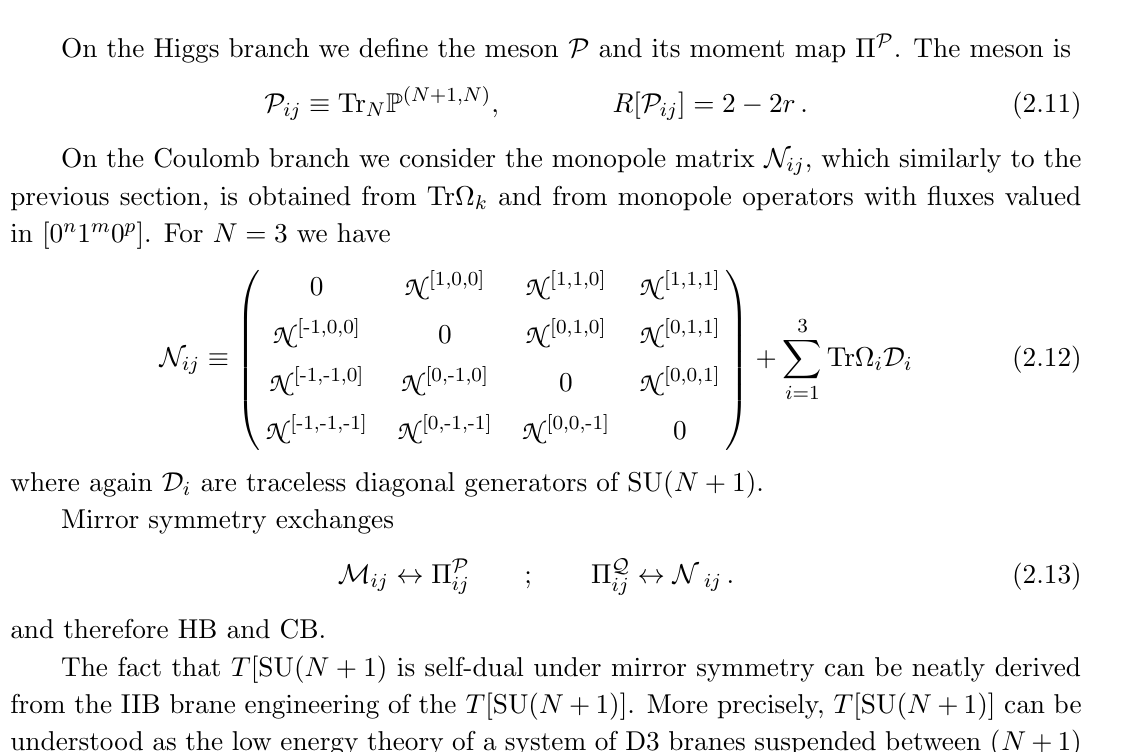
Table 1 . The brane setup giving rise to the 3d N = 4 T [SU( N + 1)] gauge